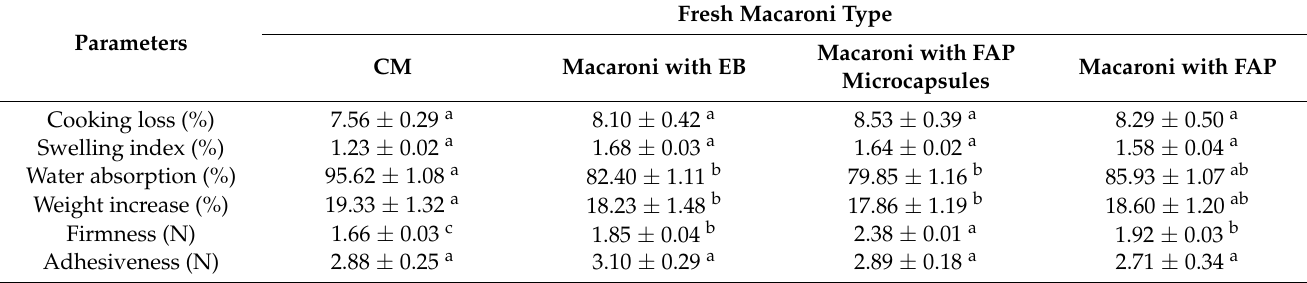
Table 4. Cooking and textural properties of the fresh macaroni formulations enriched with free or microencapsulated Azolla fern